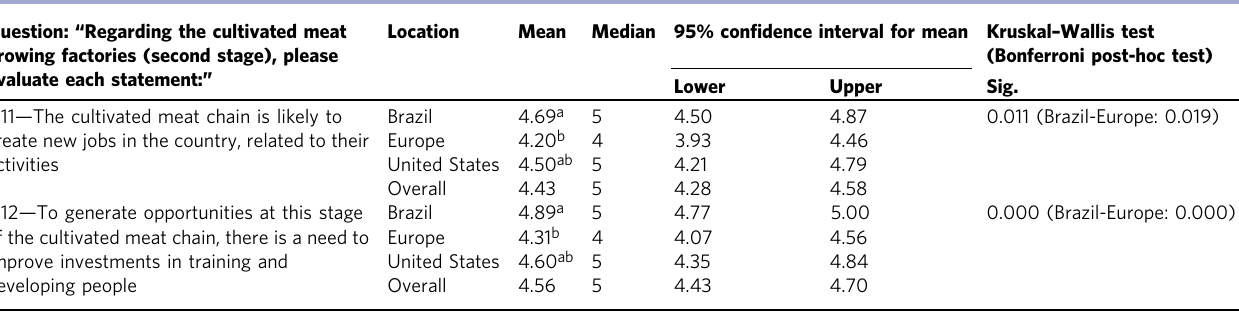
Table 9 Responses to questions regarding the impact of the second stage of cultivated meat value chain on jobs and quali fi cations in Brazil ( N = 35), Europe ( N = 56) and the United States ( N = 45) using Likert scale from 1 (strongly disagree) to 5 (strongly agree), from August to October,